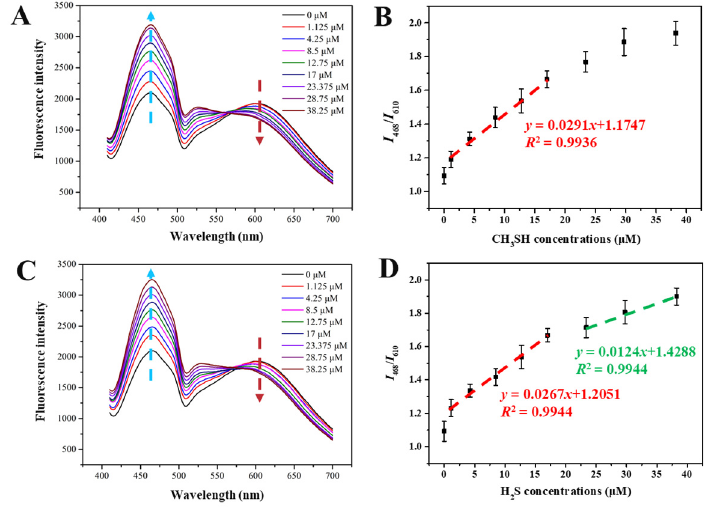
Figure 5. The fluorescent spectra of SiQD-AgNC reacting with different concentration of ( A ) H 2 S and ( C ) CH 3 SH. The relation between I 468 / I 610 and the concentrations of ( B ) H 2 S and ( D ) CH 3 SH. The linear detection range and LOD of SiQD-AgNC to H 2 S were compared with reported fluorescent sensors. As shown in Table 1, the developed SiQD-AgNC in this work was comparable to other sensors based on dyes, quantum dots, and nanoclusters. Table 1. Comparison of previously reported fl uorescent sensors and SiQD-AgNC in this work. Sensor Materials